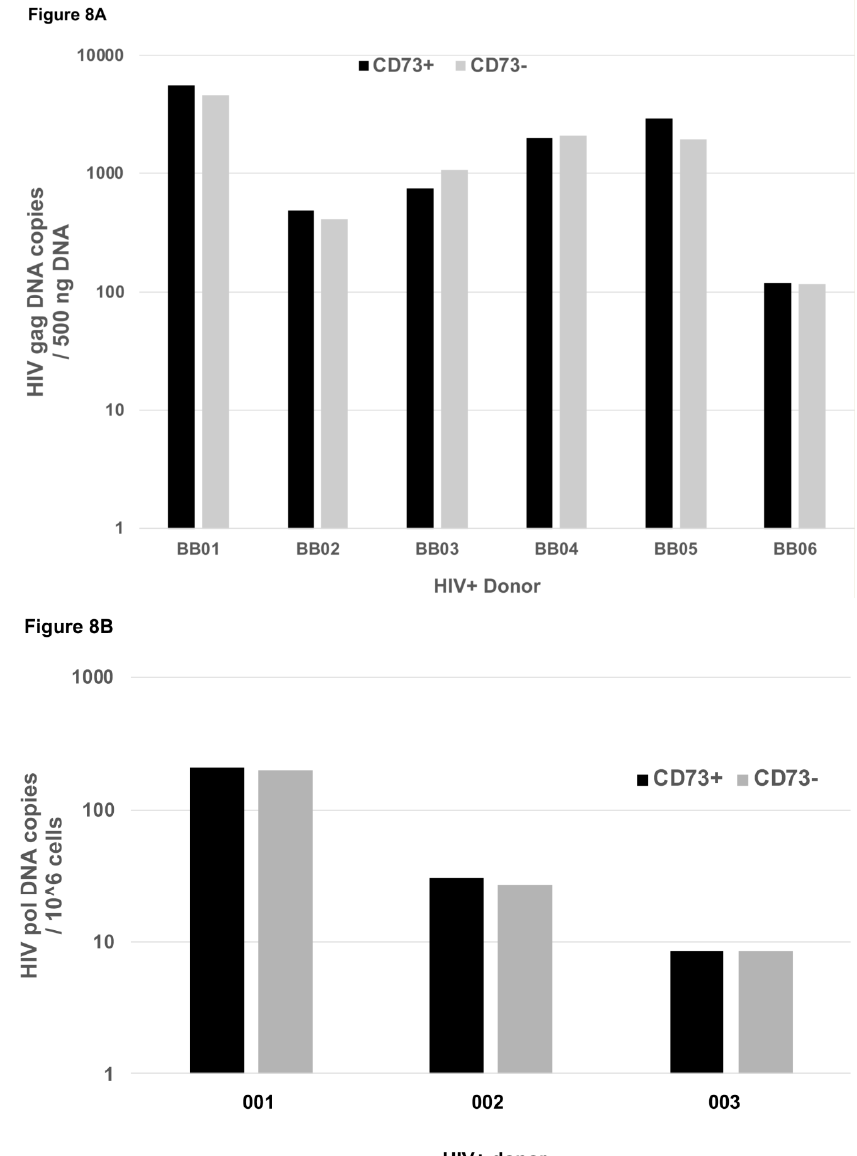
Figure 8. HIV DNA infection of CD73+ CD4+ T cells in peripheral blood. ( A ) HIV DNA gag copies (normalized to 500 ng DNA) were measured by quantitative real time PCR in purified CD73+ CD4+ T cells from cryopreserved leukapheresis product, from untreated HIV+ subjects. The graph shows the ratio of copy number in highly purified CD73+ CD4+ T cells compared to the copy number in total CD4+ T cells for n = 6 individuals. ( B ) HIV DNA pol copies (normalized to 10 6 cells) were measured by quantitative real time PCR in purified CD73+ CD4+ T cells from cryopreserved PBMC, from HIV+ subjects on long term ART. The graph shows the copy number in highly purified CD73+ CD4+ T cells compared to the copy number in CD73-negative CD4+ T cells for n = 3 individuals.